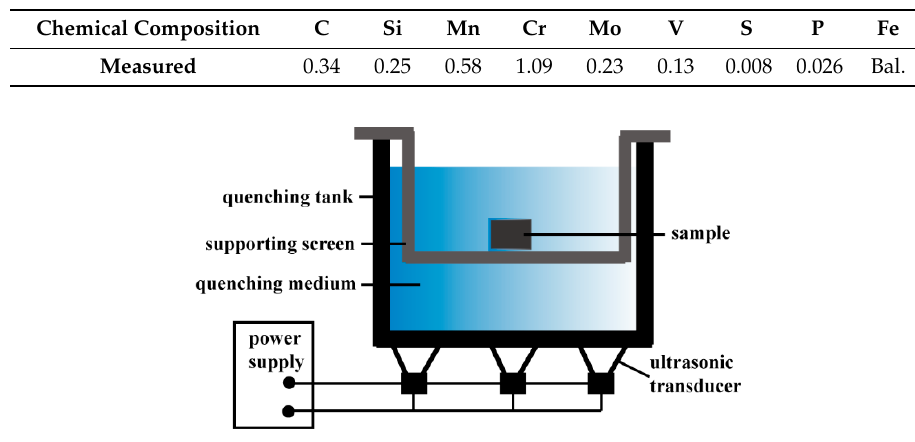
Table 1. Composition of 35CrMoV steel (wt %).